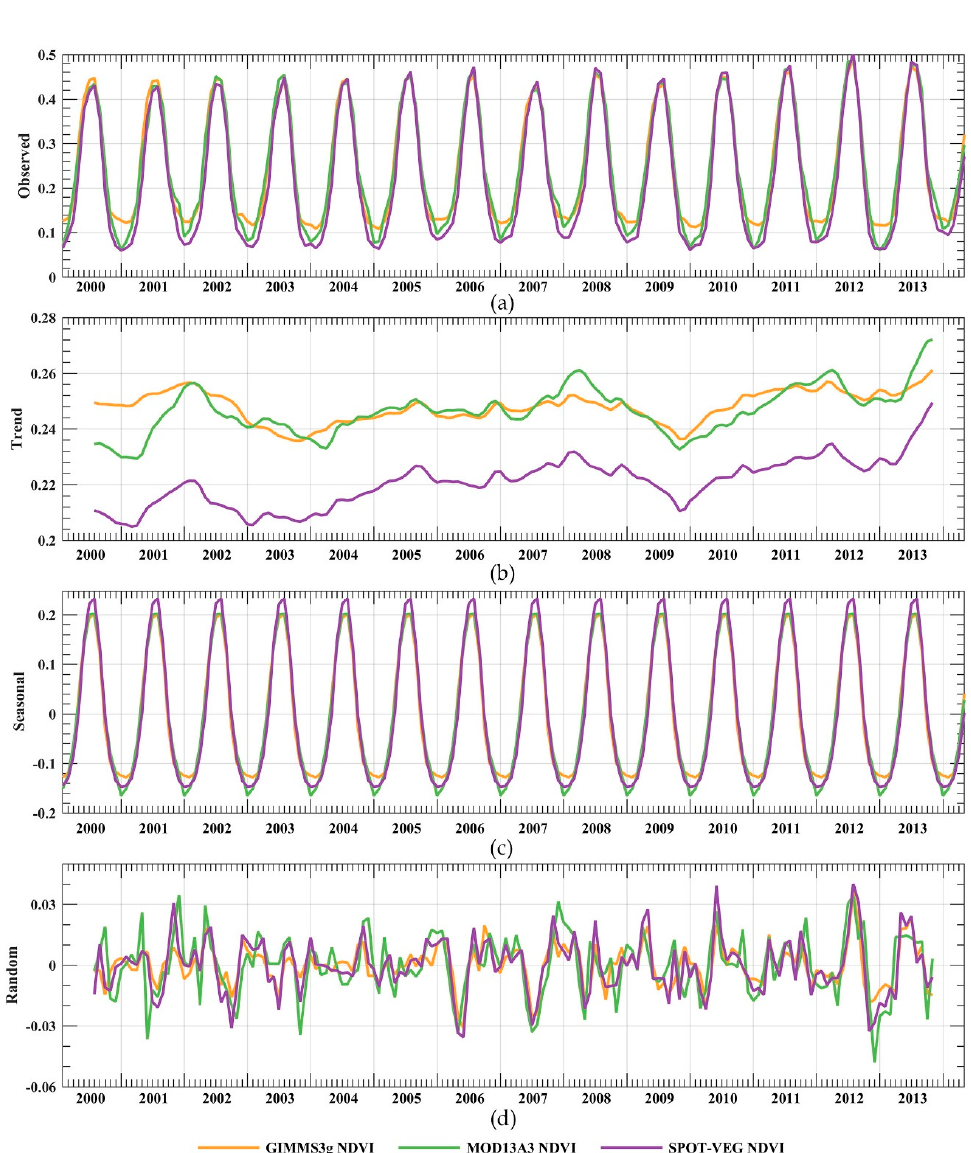
Figure 6. Time series of decomposed of GIMMS3g NDVI, MOD13A3 NDVI, and SPOT-VGT NDVI